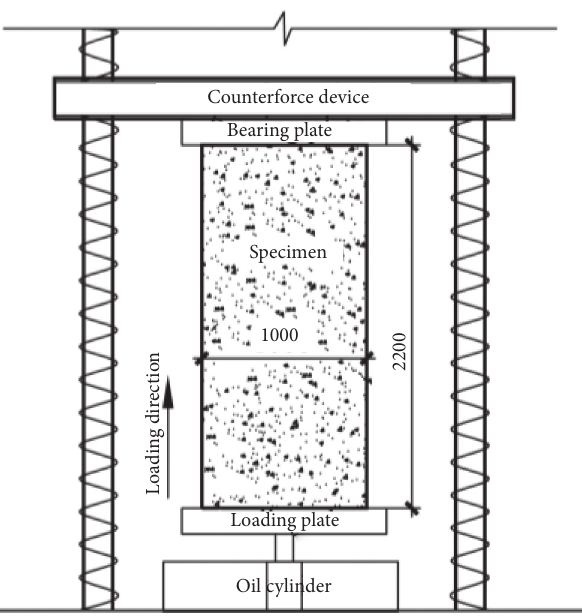
Figure 19: Loading diagram of the compressive